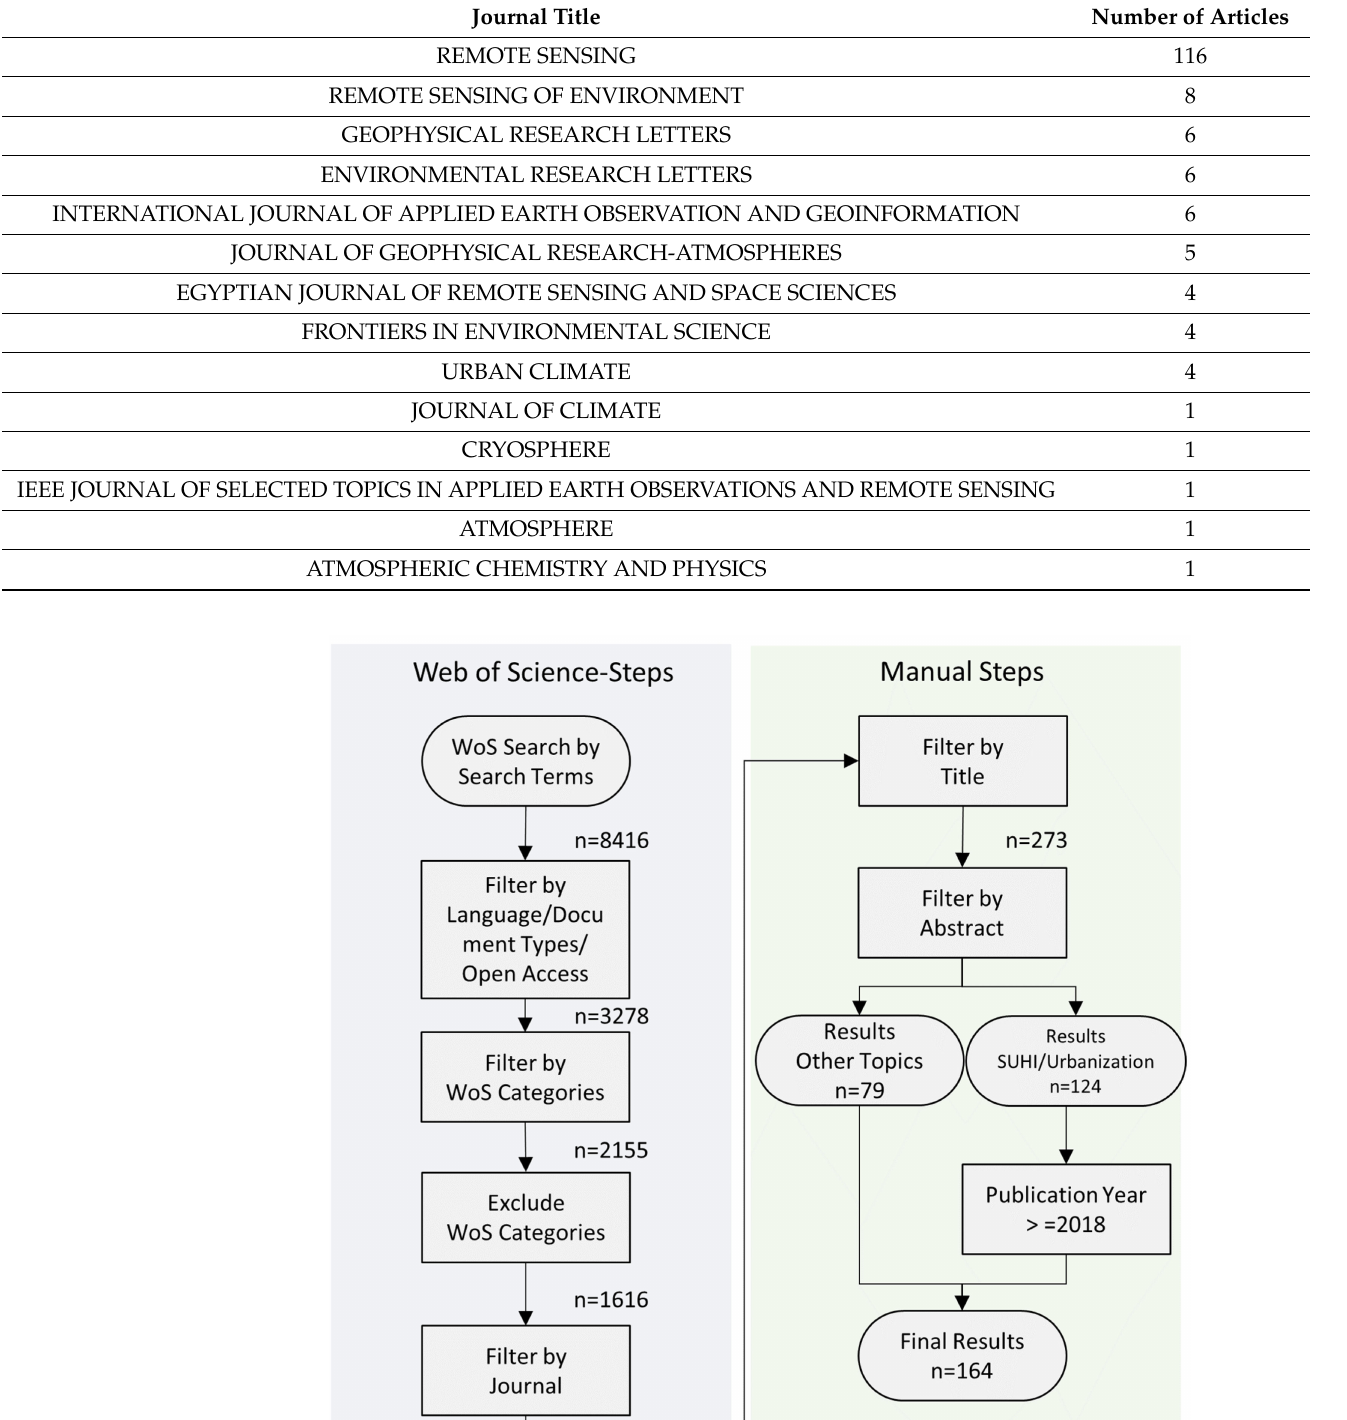
Table 1. List of the included journals and the corresponding count of reviewed articles.